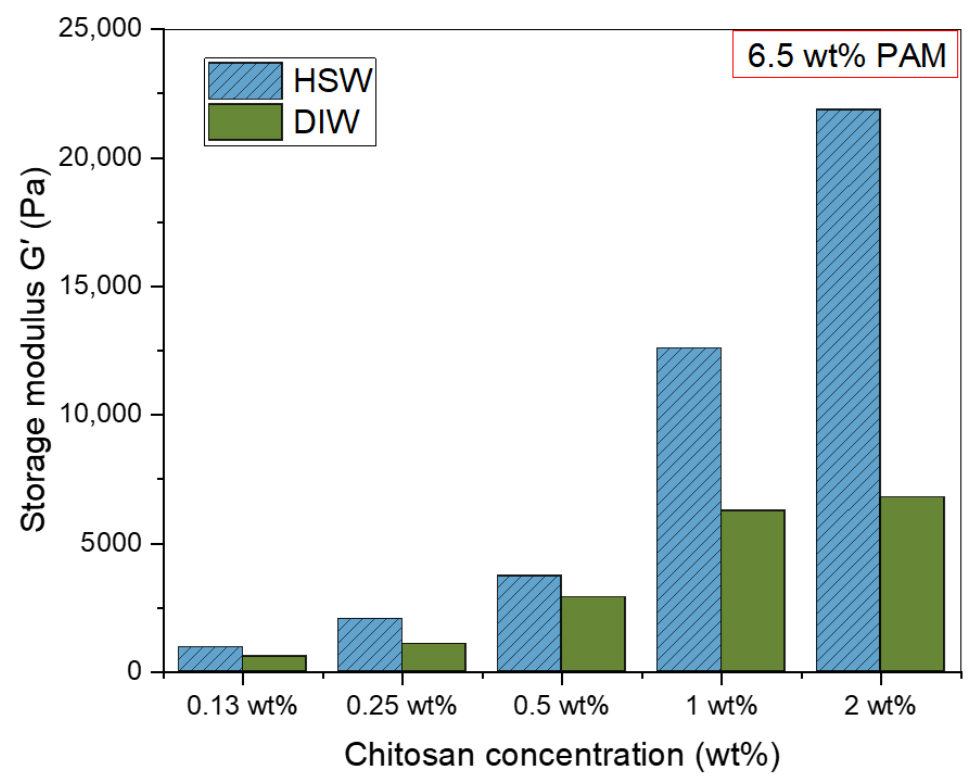
Figure 7. The effect of chitosan crosslinker concentration (0.13 – 2 wt%) on storage modulus (G’) in DIW and HSW.